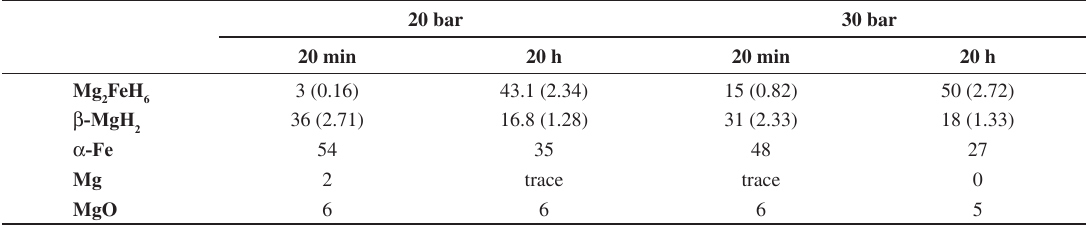
Table 1. Mass percentage of phase estimated by Rietveld refinement from the X-ray powder diffraction patterns of the 2Mg-Fe samples after the hydrogen absorption test (error ± 1%). The amount of hydrogen in mass % calculated to the hydride phases are shown in